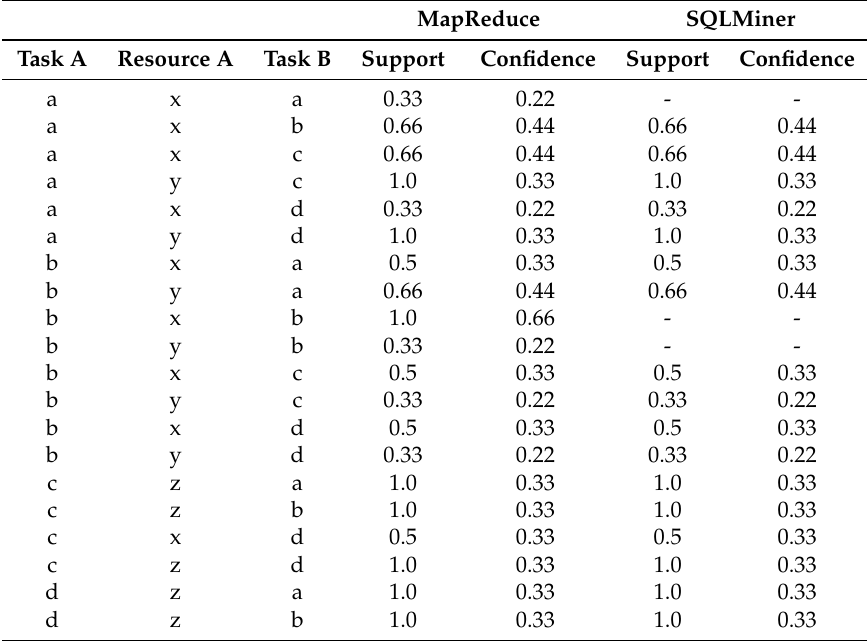
Table 23. Discovered activational Response Constraints with MapReduce and SQLMiner. MapReduce SQLMiner Task A Resource A Task B Support Confidence Support